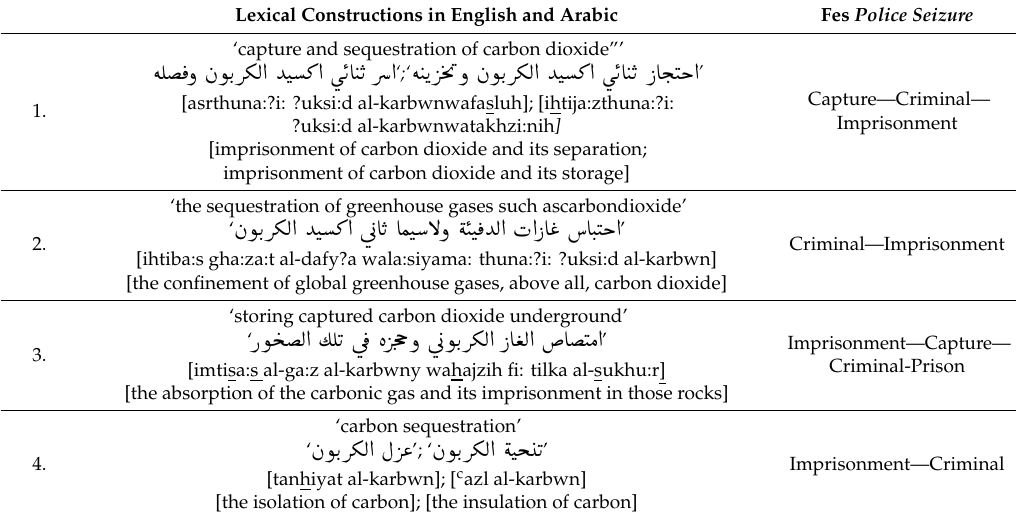
Table 4. Metaphoriclexical projection of CARBON CAPTURE AND SEQUESTRATION in English and